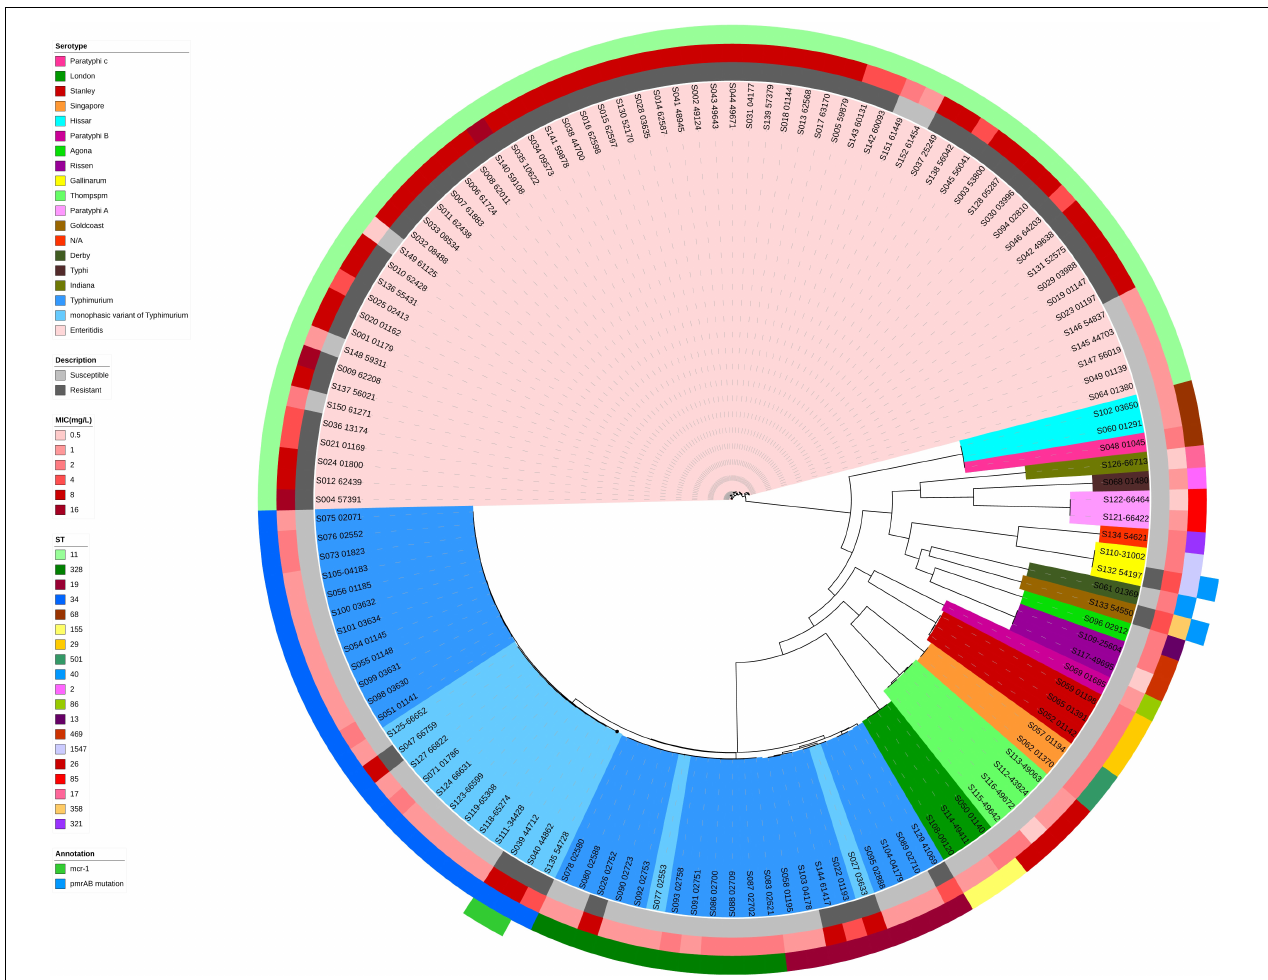
FIGURE 2 | Maximum parsimony tree of the whole-genome sequenced 136 clinical Salmonella isolates. MICs (mg/L) and sequence types of colistin among different serotype Salmonella isolates were shown. Maximum parsimony tree were generated based on core-genome SNPs by kSNP 3.0. Isolates with different serotypes are indicated in the inner ring with different colors. Colistin MICs in mg/L are shown, along with corresponding mcr-1 gene and pmrAB mutations known to be associated with phenotypic resistance. For the description of colistin susceptibility, resistance corresponds to MIC > 2 mg/L and susceptible corresponds to MIC ≤ 2 mg/L.